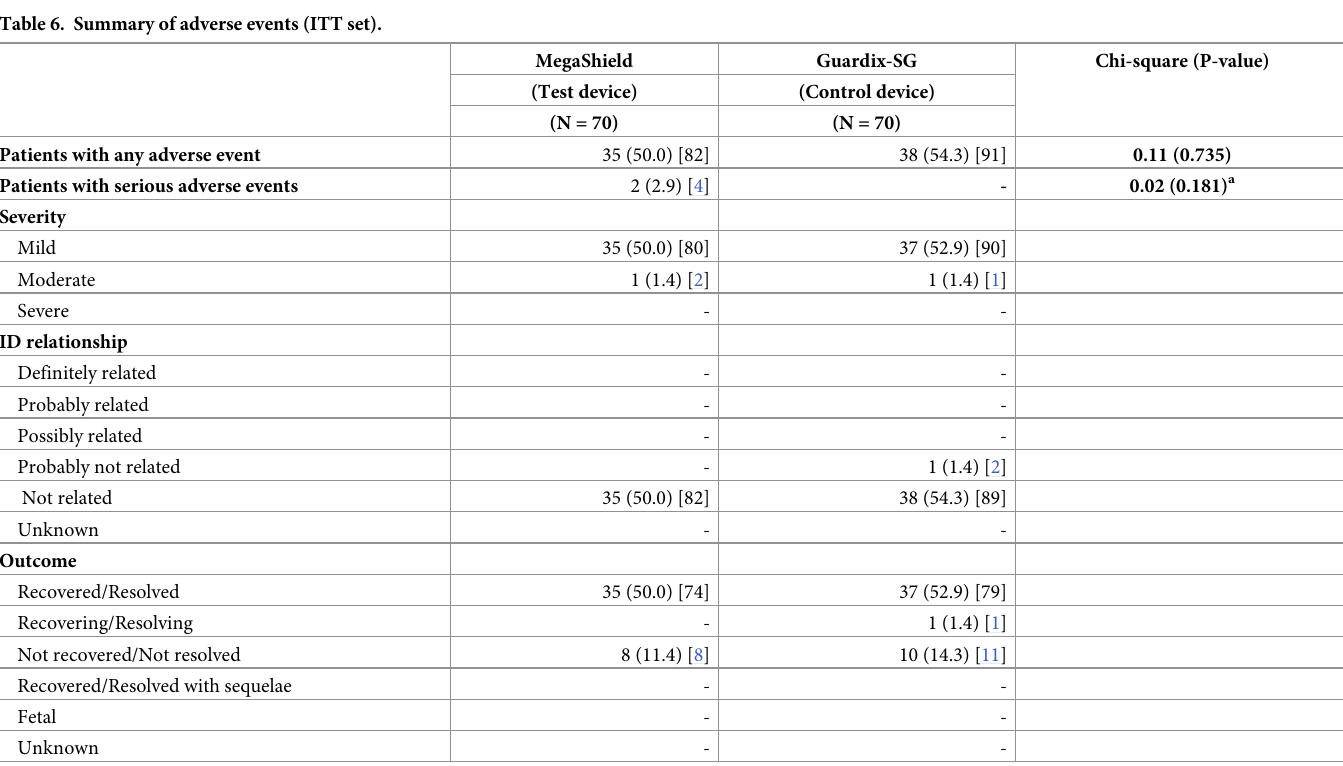
Table 6. Summary of adverse events (ITT